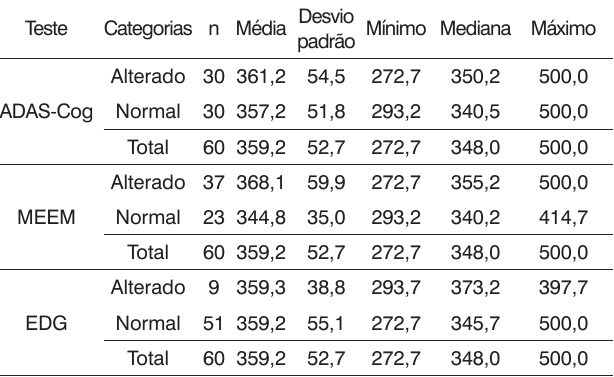
Tabela 5. Estatísticas descritivas da latência no P300 em cada categoria do ADAS-cog, MEEM e